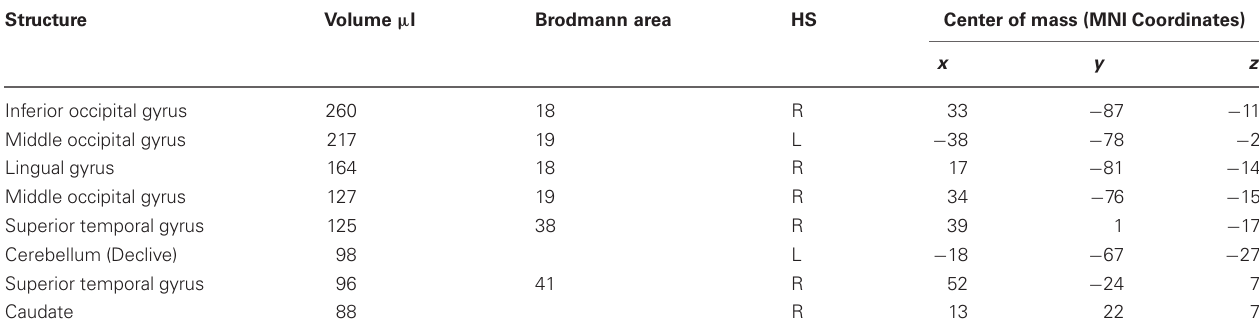
Table A2 | Regions that showed significantly greater BOLD signal change for unaware errors than for correct go-trial responses.